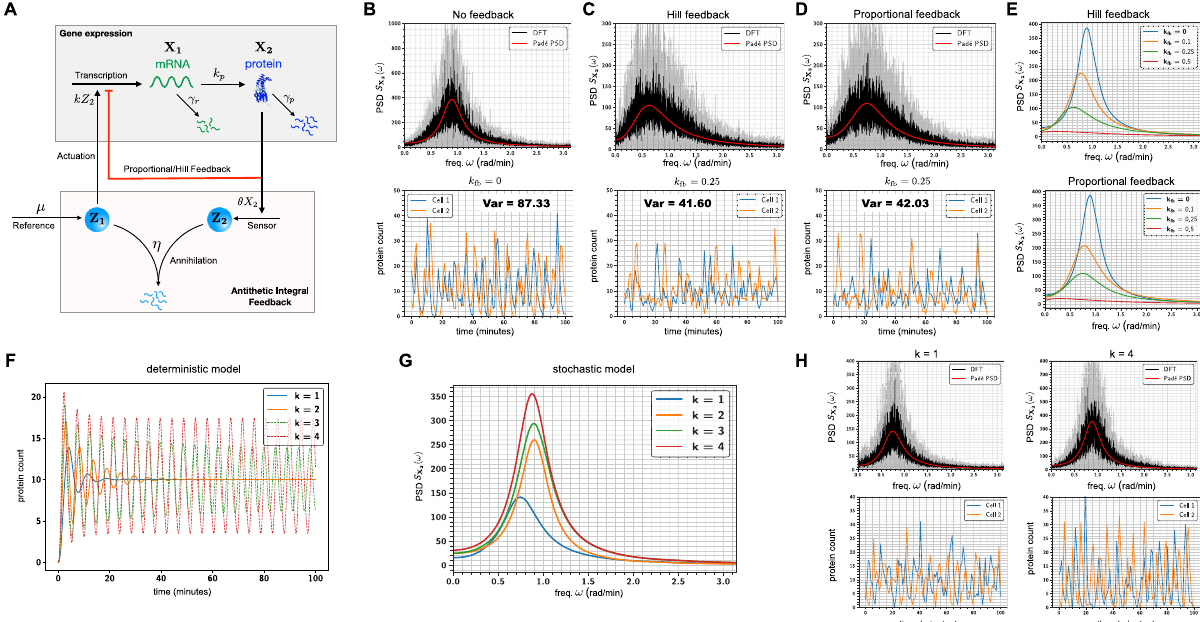
Fig. 4 Reducing single-cell oscillations due to the AIF controller. A Depiction of the biomolecular antithetic integral feedback (AIF) controller regulating the gene expression network. Here mRNA ( X 1 ) is the actuated species and the protein ( X 2 ) is the output species. This protein output is sensed by the controller species Z 2 which annihilates the other controller species Z 1 that is constitutively produced at rate μ . The species Z 1 actuates the gene expression network by catalysing the production of mRNA X 1 . The red arrow indicates an extra negative feedback from the output species (protein) to the production of the actuated species (mRNA). In B , the single-cell oscillatory trajectories for the protein counts (without the extra feedback) are plotted and the corresponding PSD is estimated with Padé PSD and the DFT method. C Same plots as in panel ( B ) for Hill feedback with k fb ¼ 0 : 25min (cid:3) 1 . D Same plots as in panel ( B ) for proportional feedback with k ¼ 0 : 25min (cid:3) 1 . For other values of k fb , comparison plots between Padé PSD and DFT are provided in fb Fig. S5(A) in the Supplement. The plots for the single-cell trajectories in panels ( B – D ) also indicate the total signal power which is equal to the stationary output variance (see Box 1). Notice the ≥ 50% reduction in this variance in the presence of feedback. E Comparison of the PSDs estimated with the Padé PSD method for the Hill and proportional feedback for three choices of feedback parameter k fb . In F, we simulate the deterministic model for this network (without the extra feedback) for four values of the actuation rate constant k . Notice that for lower values of k , the deterministic trajectories converge to a fi xed point, but for higher values of k sustained oscillations emerge. This is quite different from the stochastic case, where oscillations persist even though their power continuously decreases as k decreases, as seen in panel ( G ) from the plots of PSDs obtained with the Padé PSD method. H Comparison of the PSDs estimated with Padé PSD and the DFT method for two values of k (for other values see Fig. S5(B) in the Supplement). All the PSDs were estimated with Q = 10 simulated